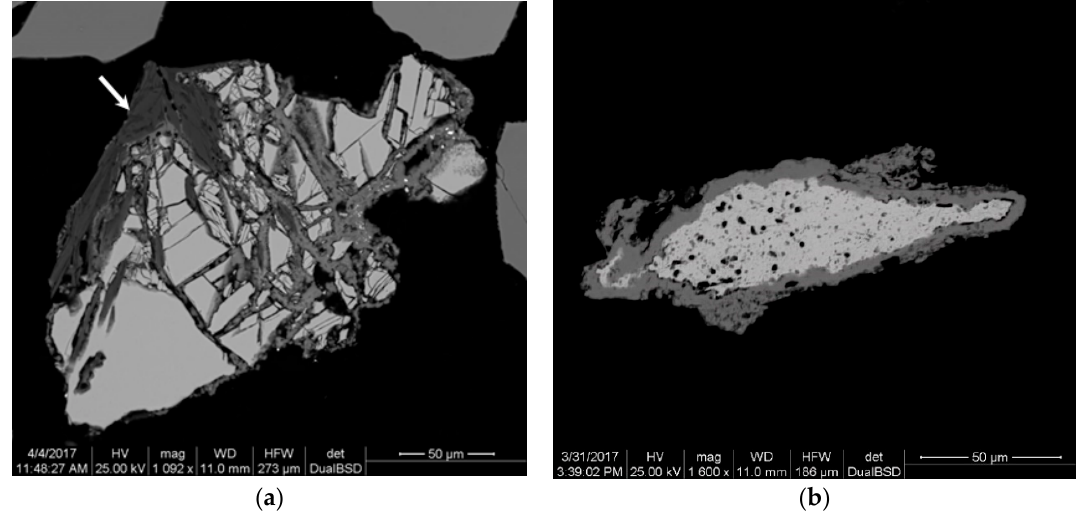
Figure 16. ( a ) Pentlandite grain with cracks filled with sulphate compounds containing a variety of elements such as iron, lead, nickel, copper, silica, etc. The dark phase on the left-hand side (arrow) is a highly altered silicate. Backscatter electron image: nitric acid-treated concentrate. ( b ) Altered galena grain now consisting of lead (with minor oxygen and trace sulphur) rimmed by lead sulphate. Note the dissolution channels in the highly altered mineral grain. Backscatter electron image: nitric acid treated concentrate.